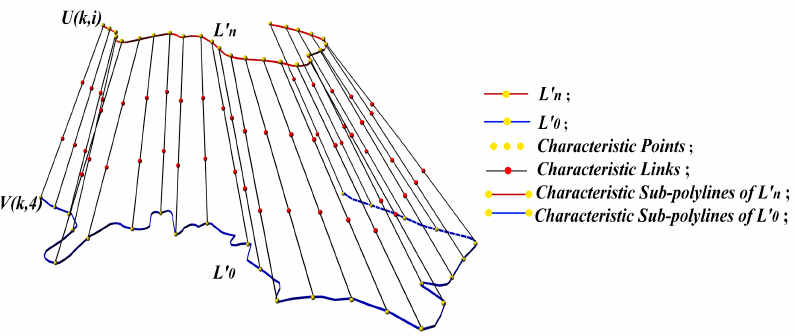
Figure 3. WF comprising the characteristic points, characteristic sub-polylines, and characteristic links.